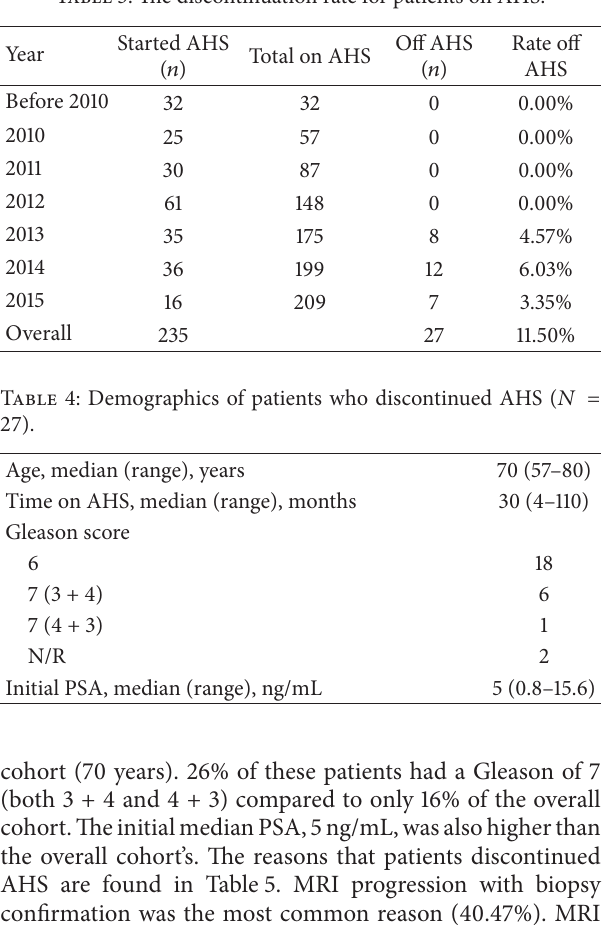
Table 3: The discontinuation rate for patients on AHS.